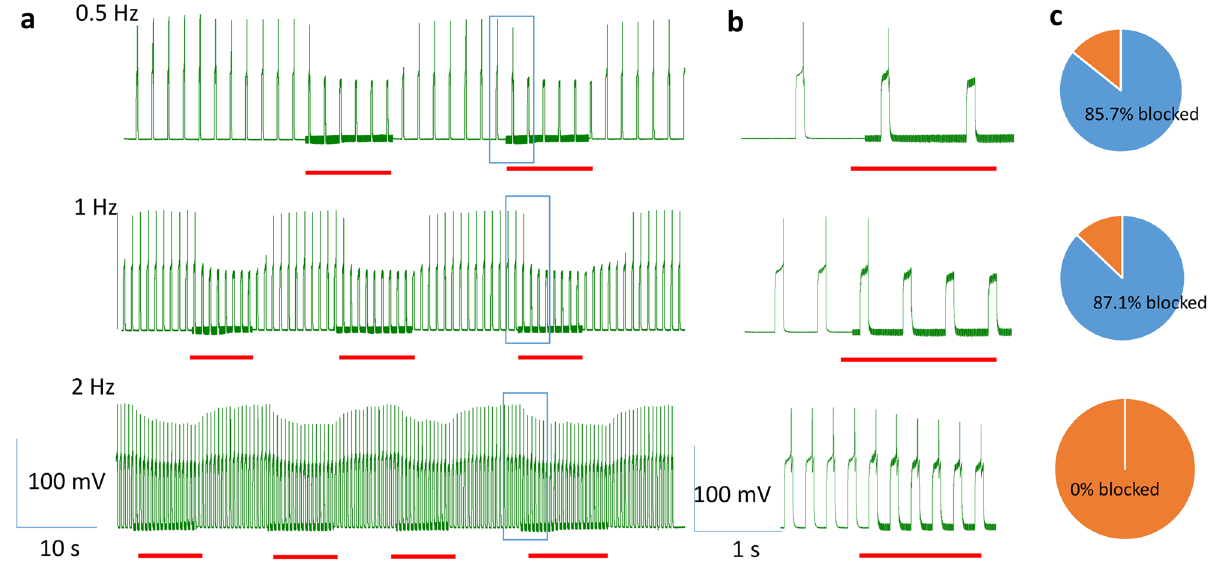
Figure 7. Magnetic inhibition is dependent on the level of neuronal activity induced by pulse stimulation. The neuron was elicited to fire a single action potential by short current pulses at 0.5, 1, and 2 Hz, respectively. The coil stimulated the soma at 400 Hz for approximately 10 s (red bars). ( a ) Magnetic stimulation inhibited the soma firing at a low rate (0.5 and 1 Hz) but did not block the soma firing at a higher rate (2 Hz). ( b ) Expanded traces of the blue rectangles in (a). ( c ) Percentage of successful blockage by the magnetic field in multiple